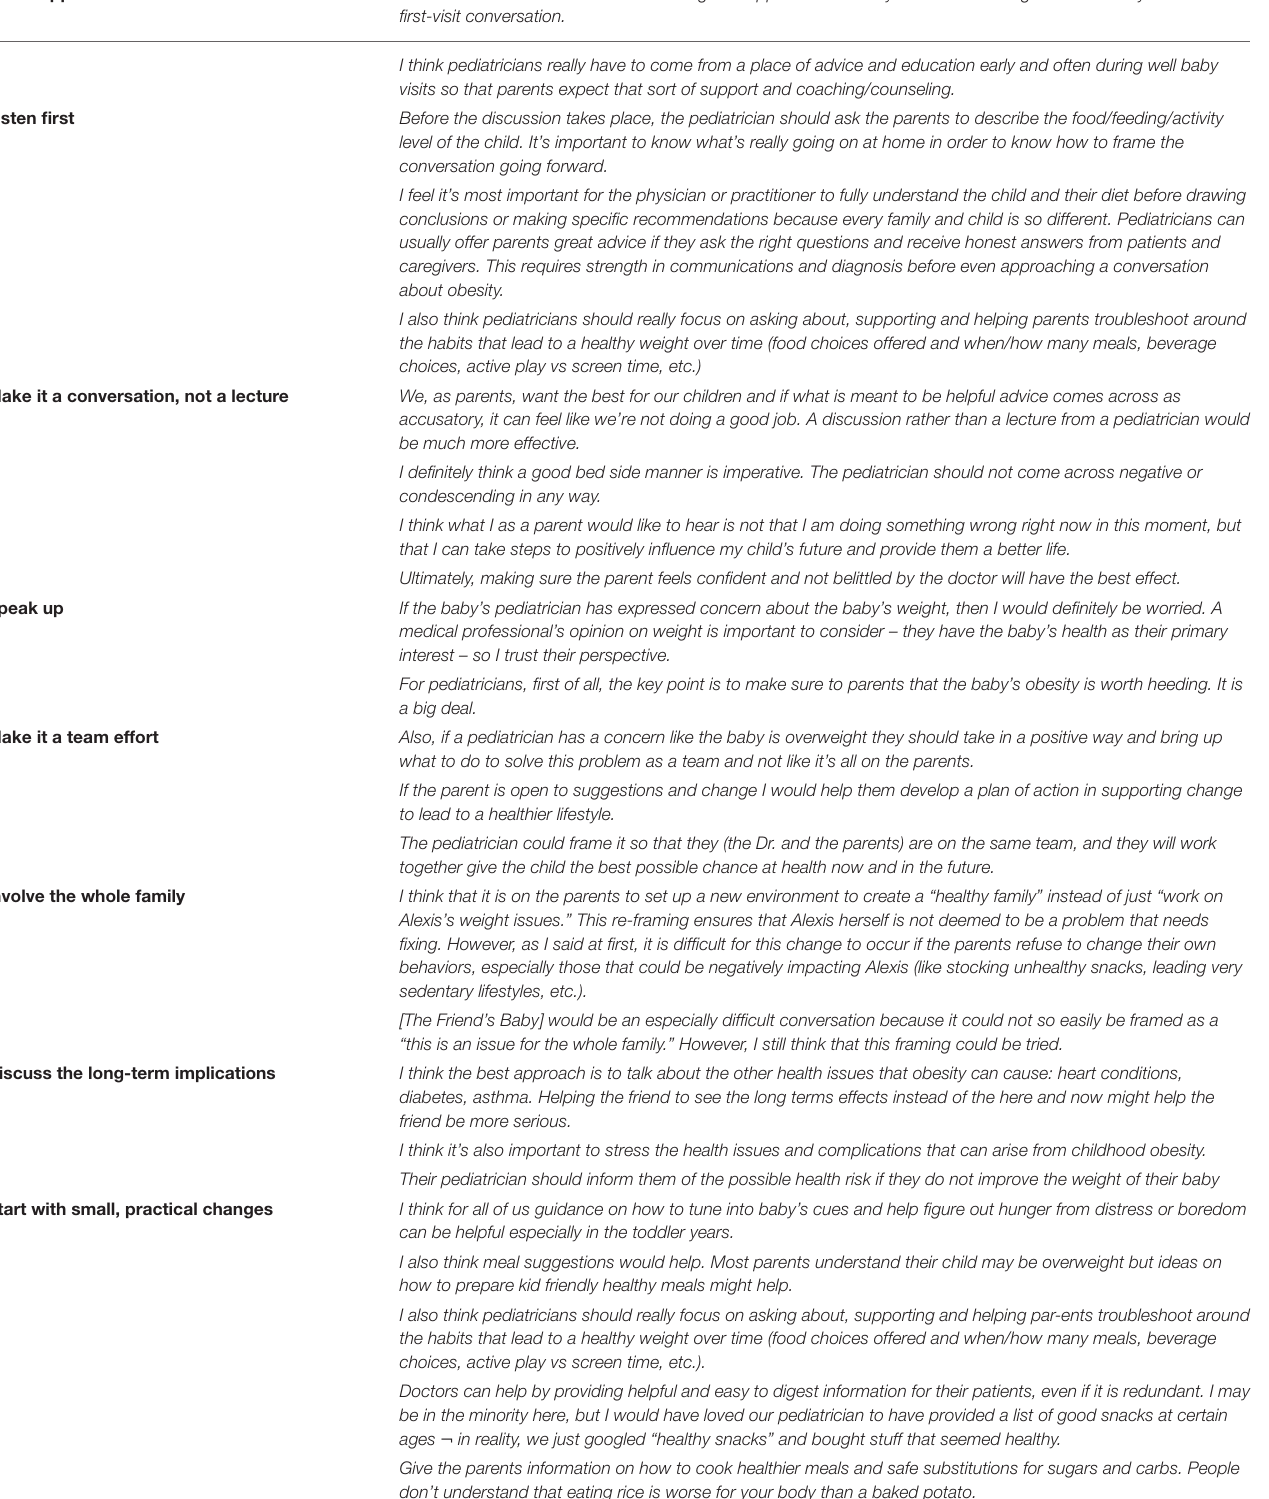
TABLE 4 | Parental preferences regarding early life obesity risk communication. Build